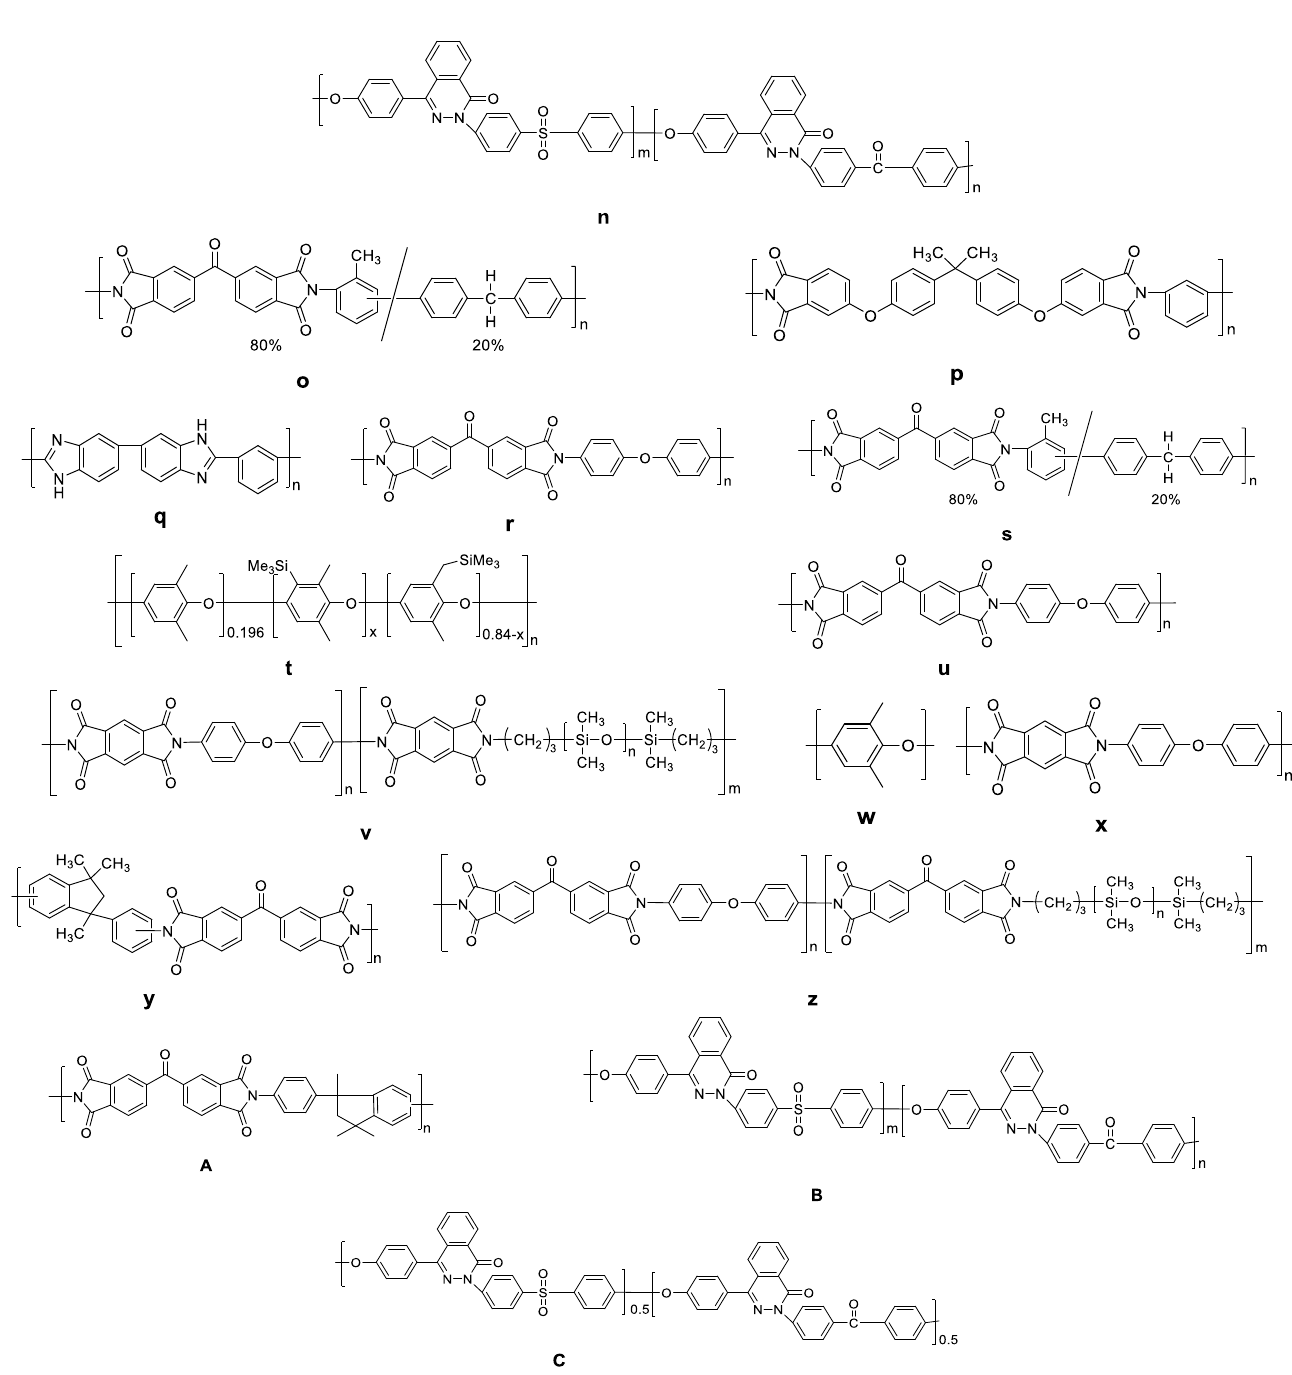
Chart 7. Chemical structures of the precursor polymers of CMSMs in Figure 10 (CMSMs in 2020).